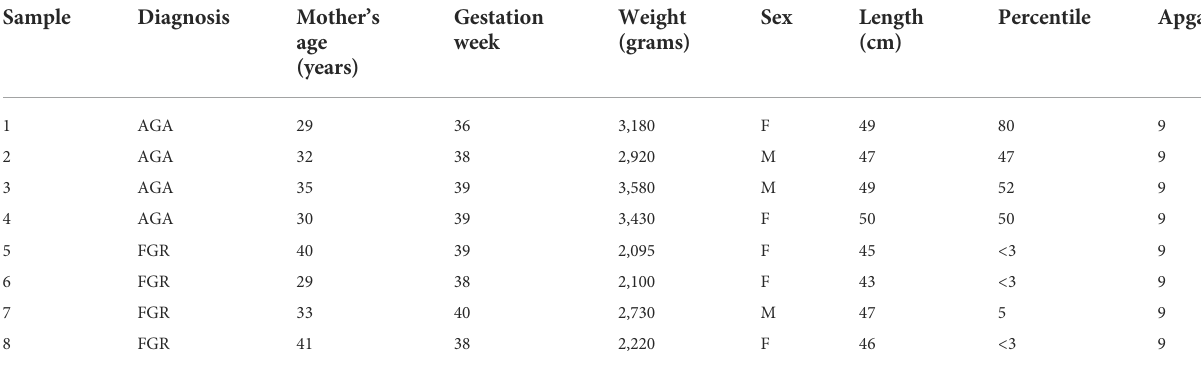
TABLE1Collection ofFGRandAGA umbilicalcordsamples.AGA:Appropriatefor GestationalAge, FGR:FoetalGrowthRestriction.The Apgarscoreis used to quantify the neonatal wellbeing, based on fi ve parameters (Appearance, Pulse, Grimace, Activity, Respiratory effort). Scores of seven or above are considered